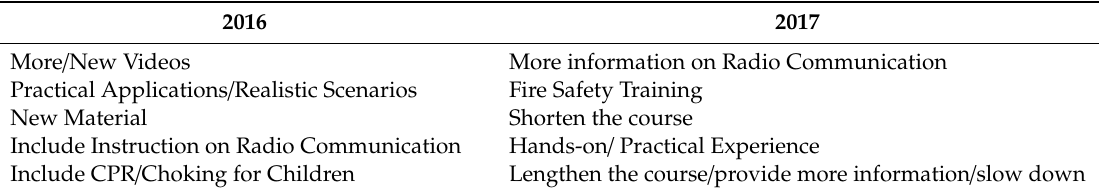
Table 3. Top five suggestions for improvement from training survey: baseline (2016) vs. update (2017).